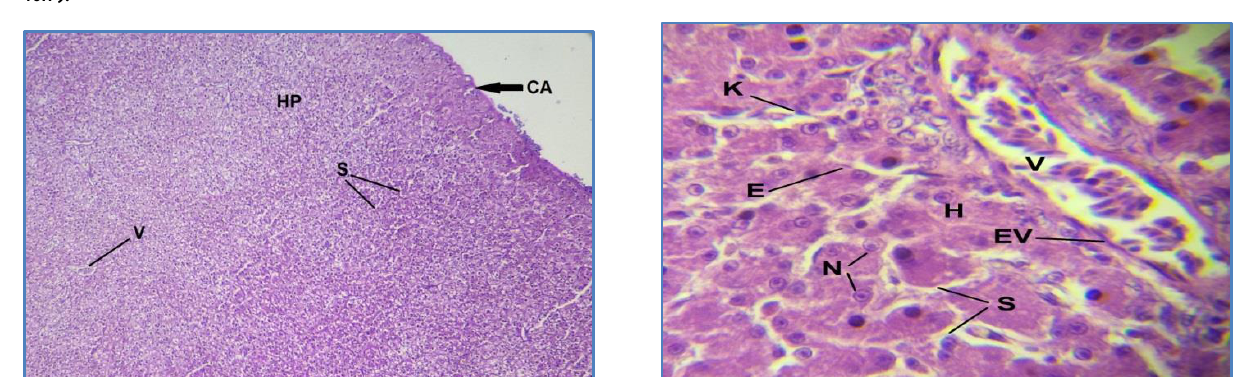
Figure, 5: Histological section of the liver in mallard duck shows, the capsule (CA), hepatocyte (H), sinusoids (S), vein (V) (H and E 40X).